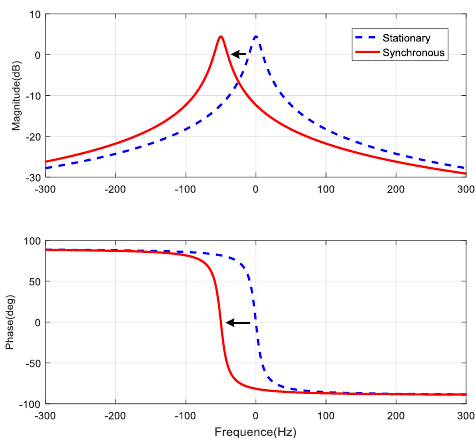
Figure 3. The frequency-response function (FRF) of the controlled object in the rotating coordinate system and the stationary coordinate system.